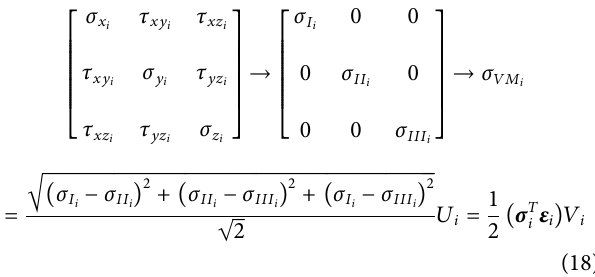
Figure 6 : the squeeze action, due to the y -component of the eccentricity vector e , causes the pressure bell-shape within the socket surface and the deformation needed to keep the surface separated. The z -component of the angular velocity vector ω is